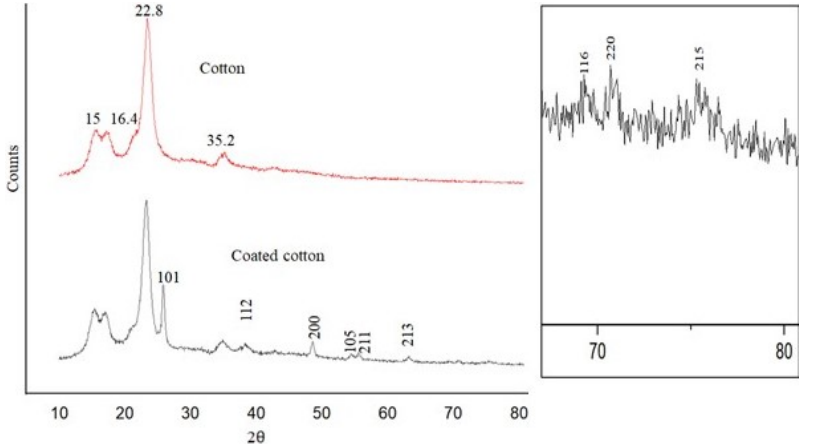
Figure 4. XRD pattern of synthesized modified nano titania.